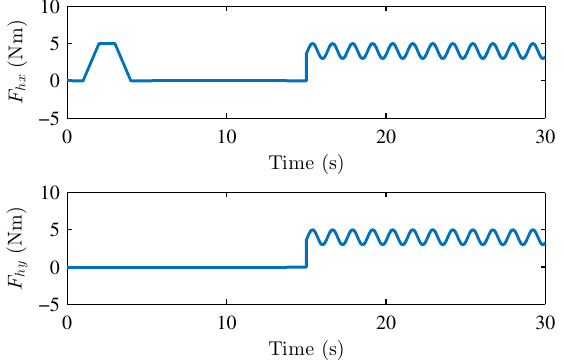
Figure 3. External operator torques F hx in x-direction and F hy